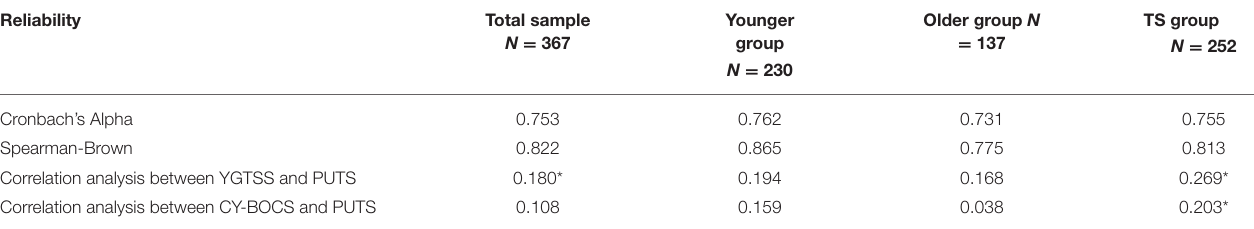
TABLE 3 | Reliability and correlation analysis of PUTS.